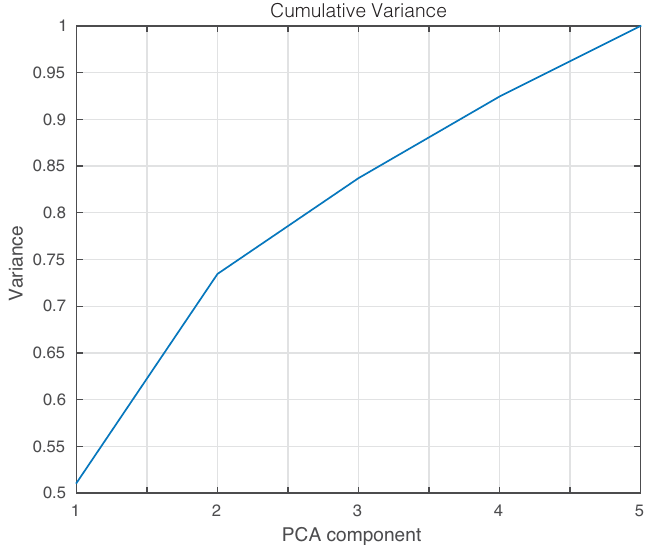
Figure 22. Cumulative variance for the scores of PCA. Table 2. Percentage of correct decisions for the healthy structure and the structure with Damages 1, 2 and 3, for the twenty different machine learning strategies (composite